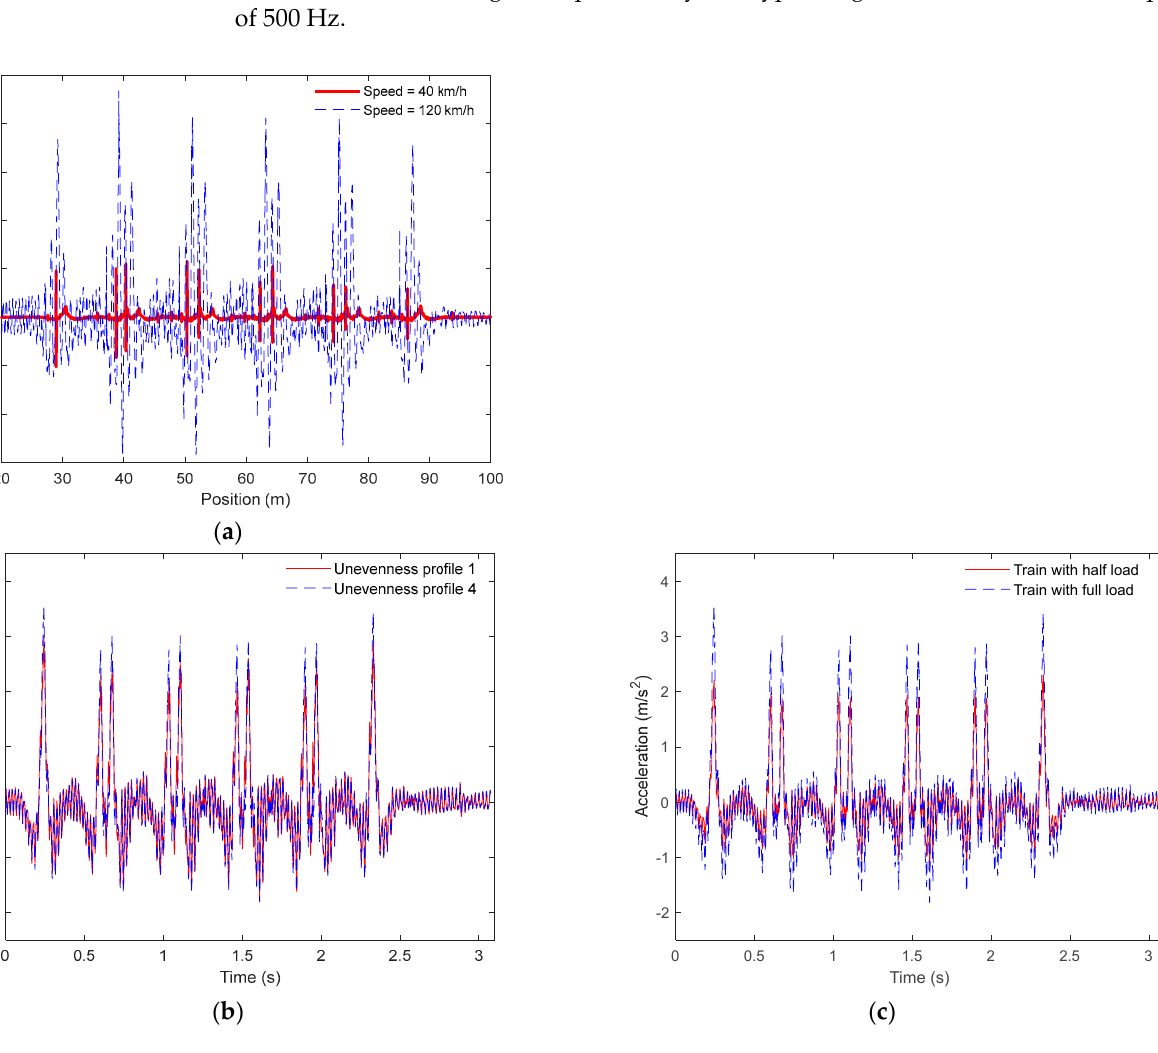
Figure 5. Acceleration time series for sensor 3 for a freight train considering a healthy wheel (baseline scenario): ( a ) influence of vehicle speed, ( b ) influence of the unevenness profile, ( c ) influence of the loading schemes.